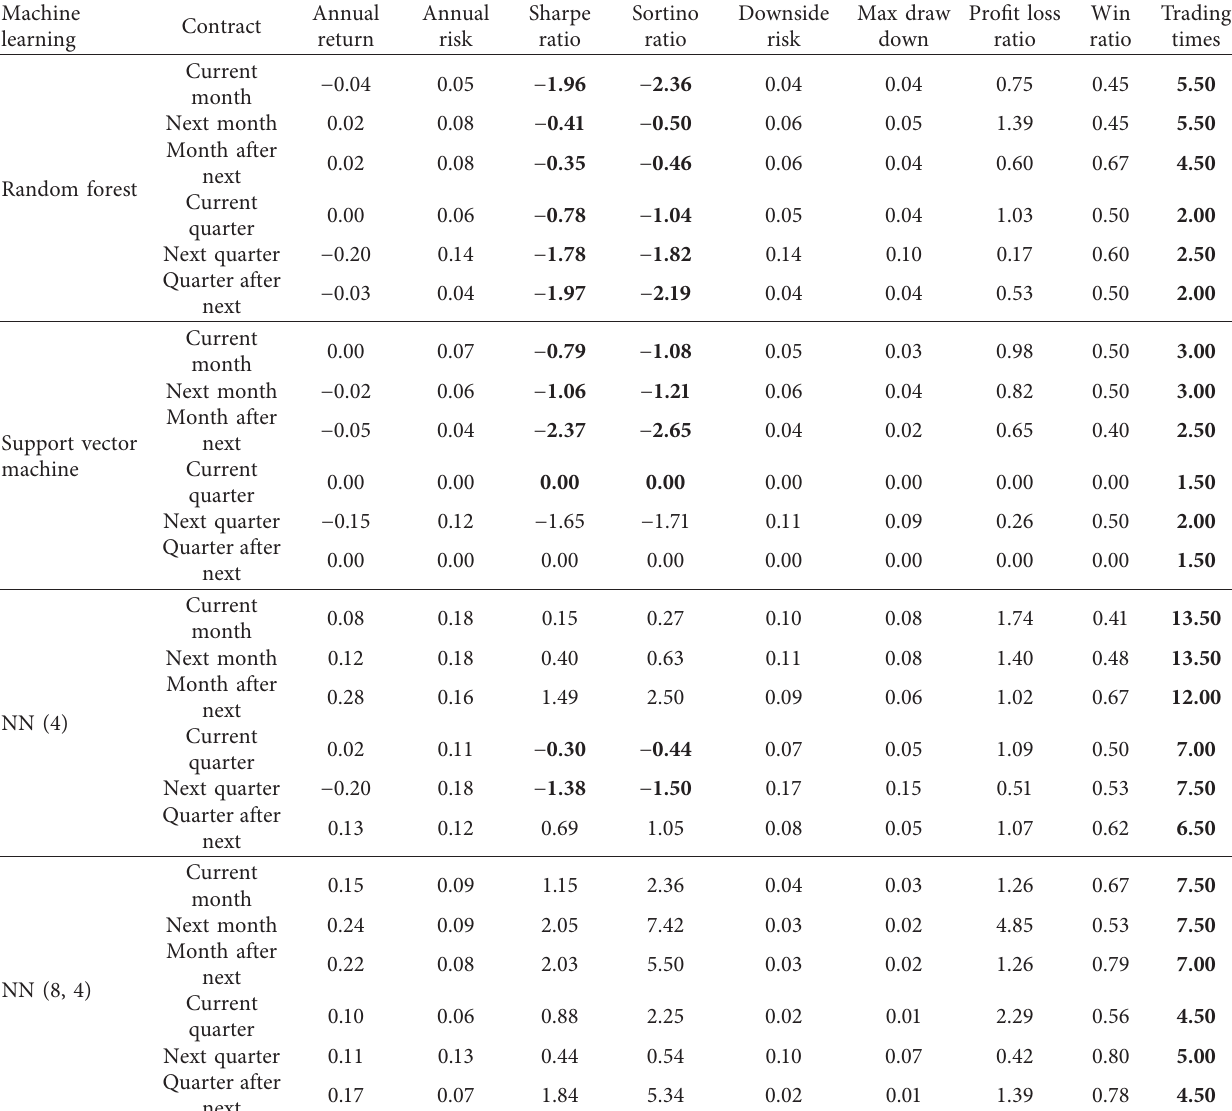
Table 17: Option strategy of predicting the rise and fall of volatility by threshold (use 21 features M3, threshold � 0.7). Machine